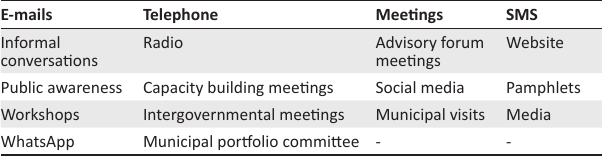
TABLE 3: Information sharing